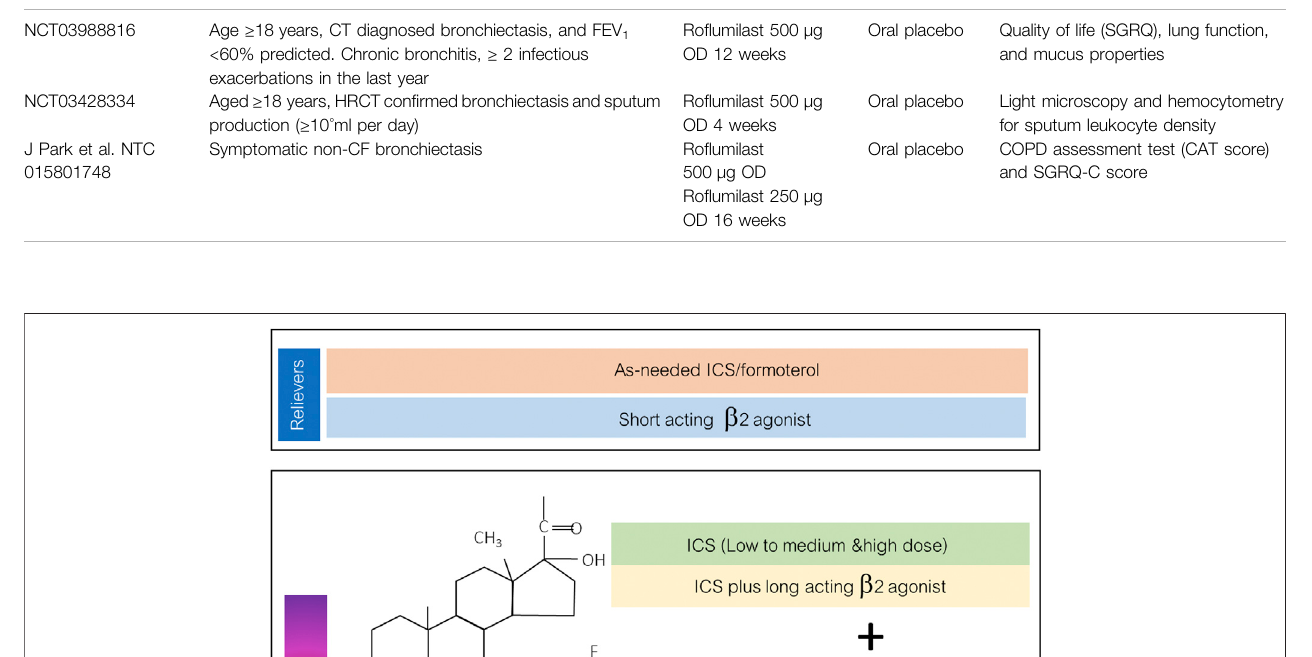
Frontiers in Pharmacology |